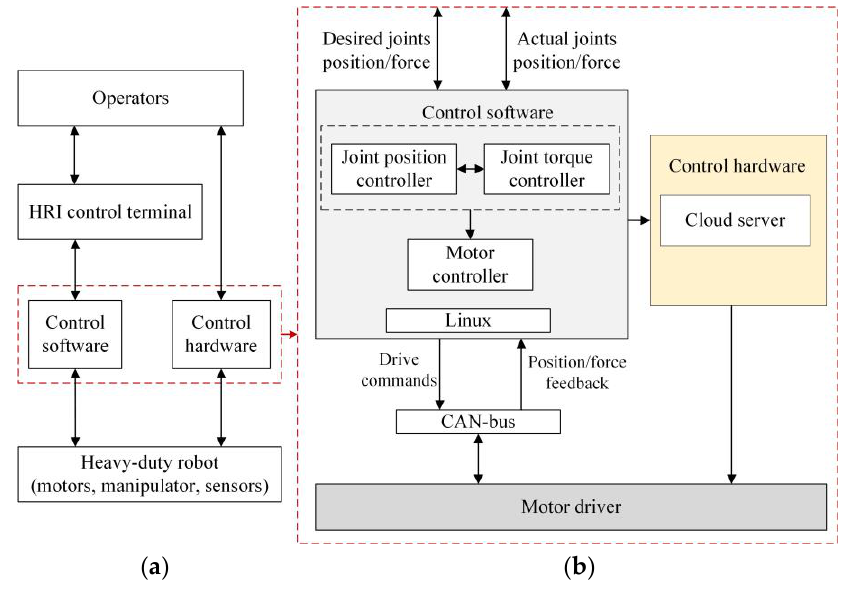
Figure 1. ( a ) The heavy-duty robot system component; ( b ) Control system.